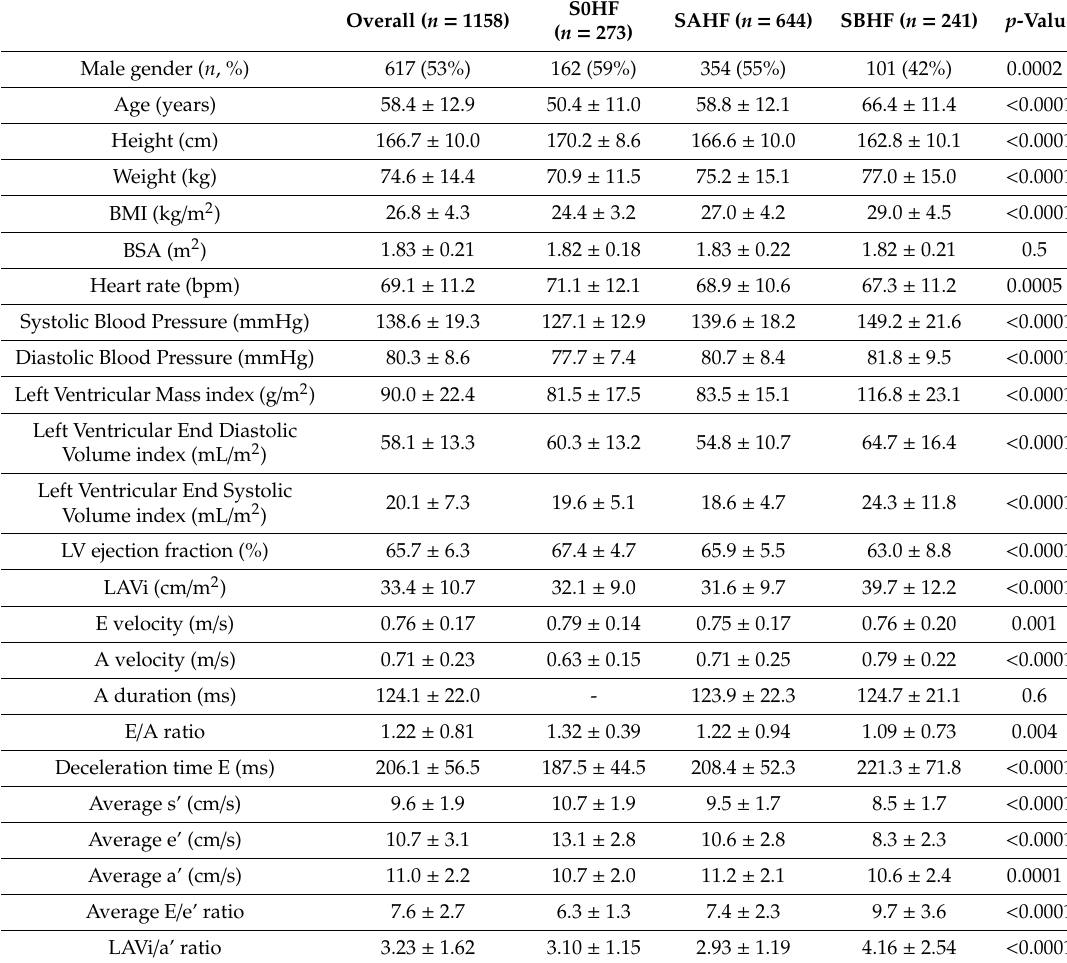
Table 1. Clinical and echocardiographic characteristics of overall population and according to Heart Failure Stage 0, A and B (S0HF, SAHF,